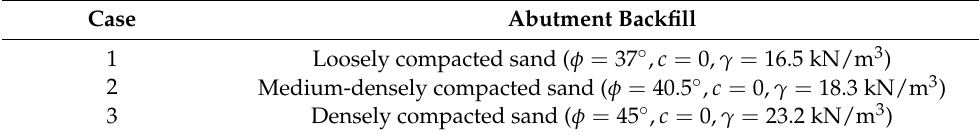
Table 1. Backfill soil